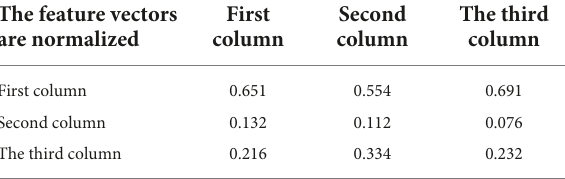
TABLE 2 Eigenvector normalization